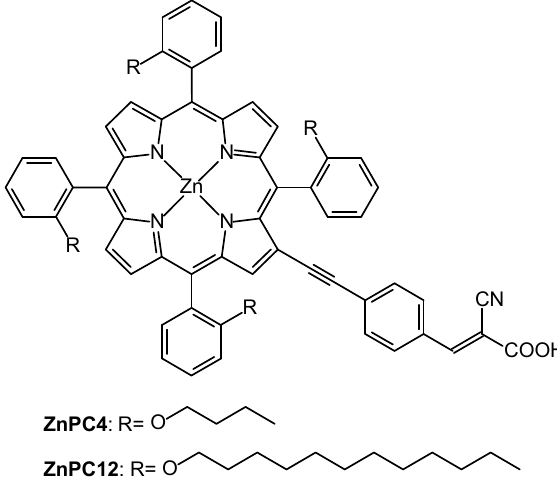
Figure 1. Dye-sensitizers